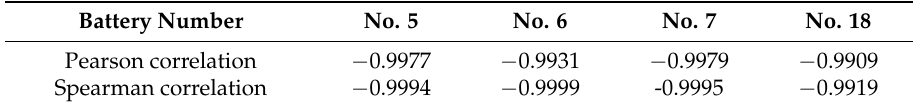
Table 1. Effectiveness analyses of HI based on